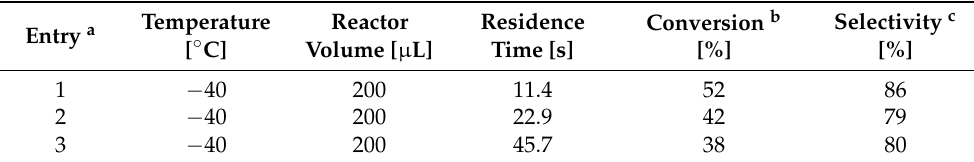
Table 3. Reduction using DIBAL-H in the alternating diameter reactor (Reactor C).